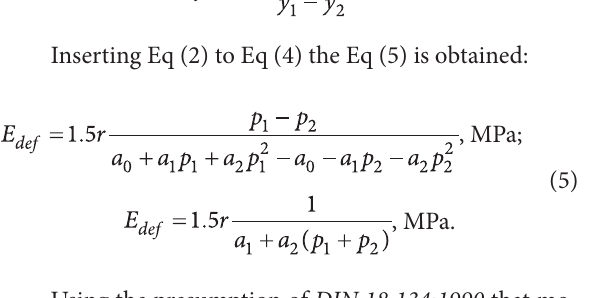
fig. 1. Static plate loading test